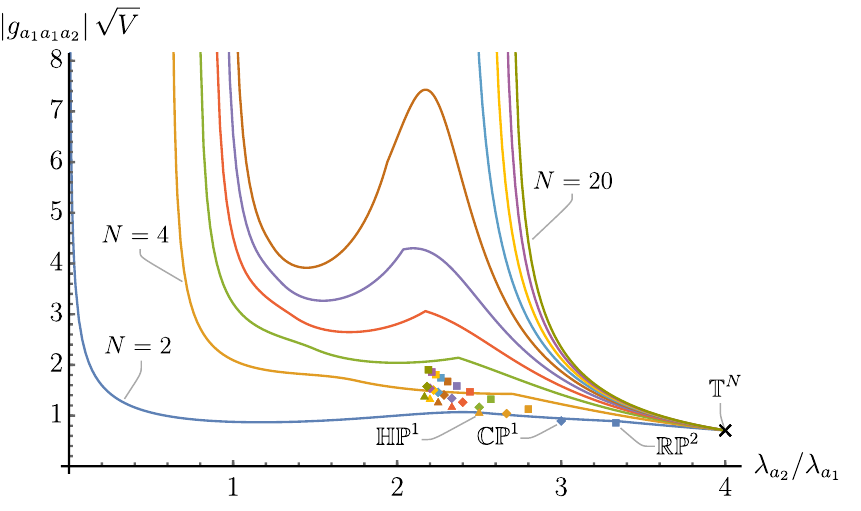
jp V for closed Einstein man- 1 a 1 a 2 =(cid:21) a , where (cid:21) a 2 f (cid:21) a g [ [ (cid:21) a ; 1 ) and 2 1 1 2